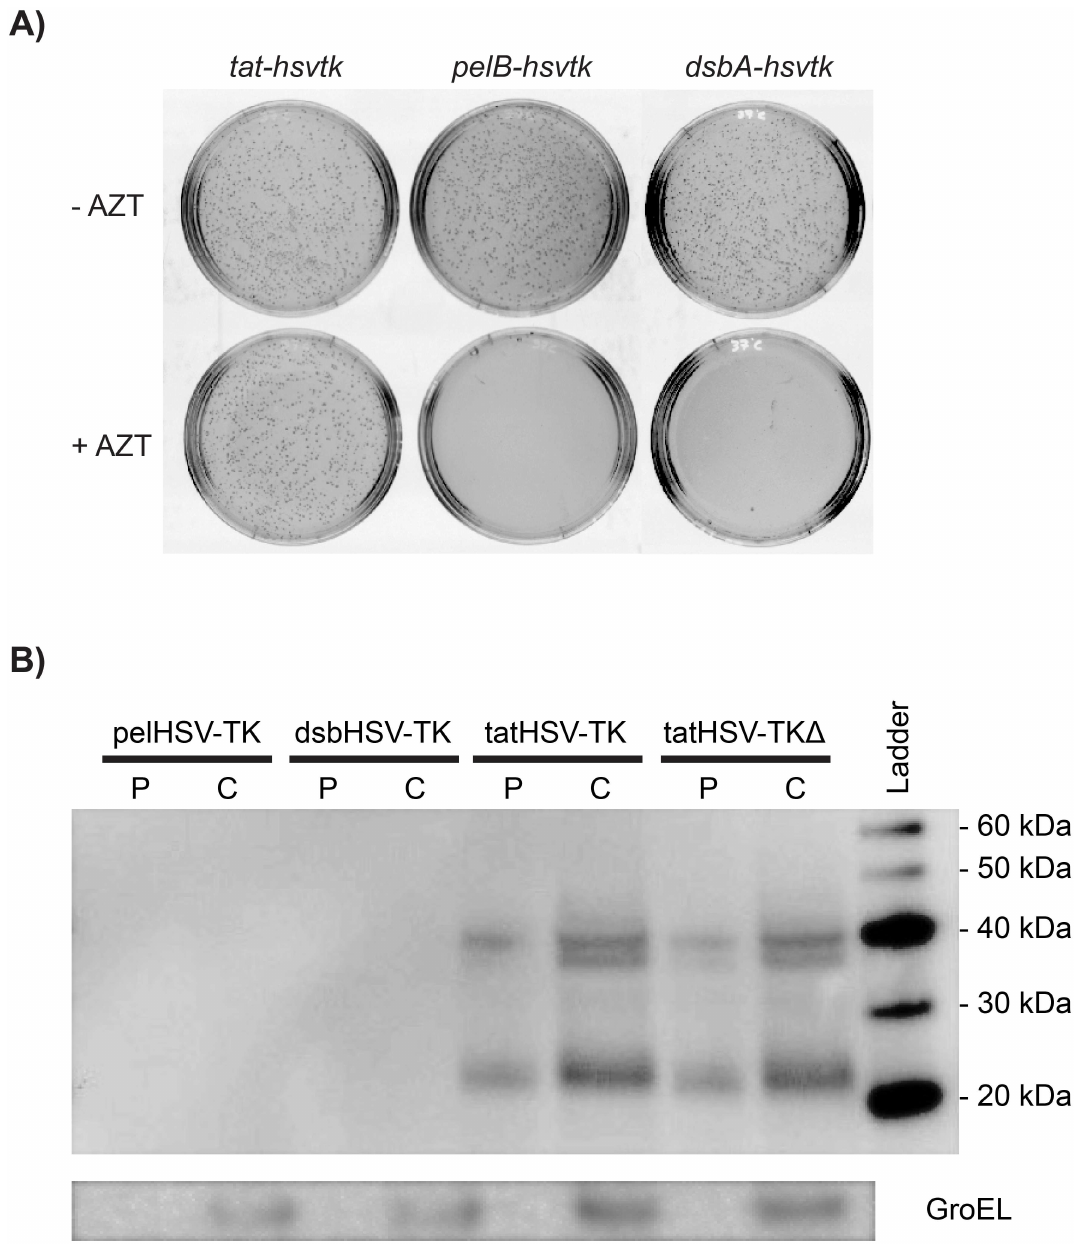
Fig 2. Export of active HSV-TK using the tat signal sequence. A) 2500 CFUs of E . coli BW14012 cells with tat-hsvtk , pelB-hsvtk or dsbA-hsvtk were plated on LB agar plates containing50 μ g/mL streptomycin, 2.5 mM ATP, 1mM IPTG, and the presence (bottom row) or absence (top row) of 10 μ g/mL AZT. The plates were incubatedfor 20 hours at 37˚C. B) Western blot using anti-HSV-TK antibodiesof periplasmic (“P”) and cytoplasmic (“C”) fractions of cells expressingthe indicatedproteins. The expect size of HSV-TK is 41 kDa. A control using anti-GroEL antibodieswas used to confirm there was no cytoplasmic protein contamination in the